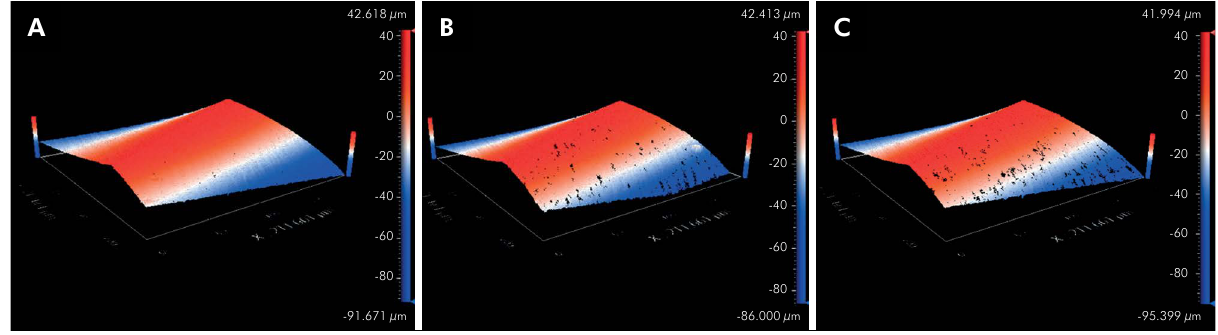
Figure 1. Three-dimensional high-resolution optical profilometry images of the cutting blade of a Reciproc instrument, before use (a) and after the first (b) and second (c)